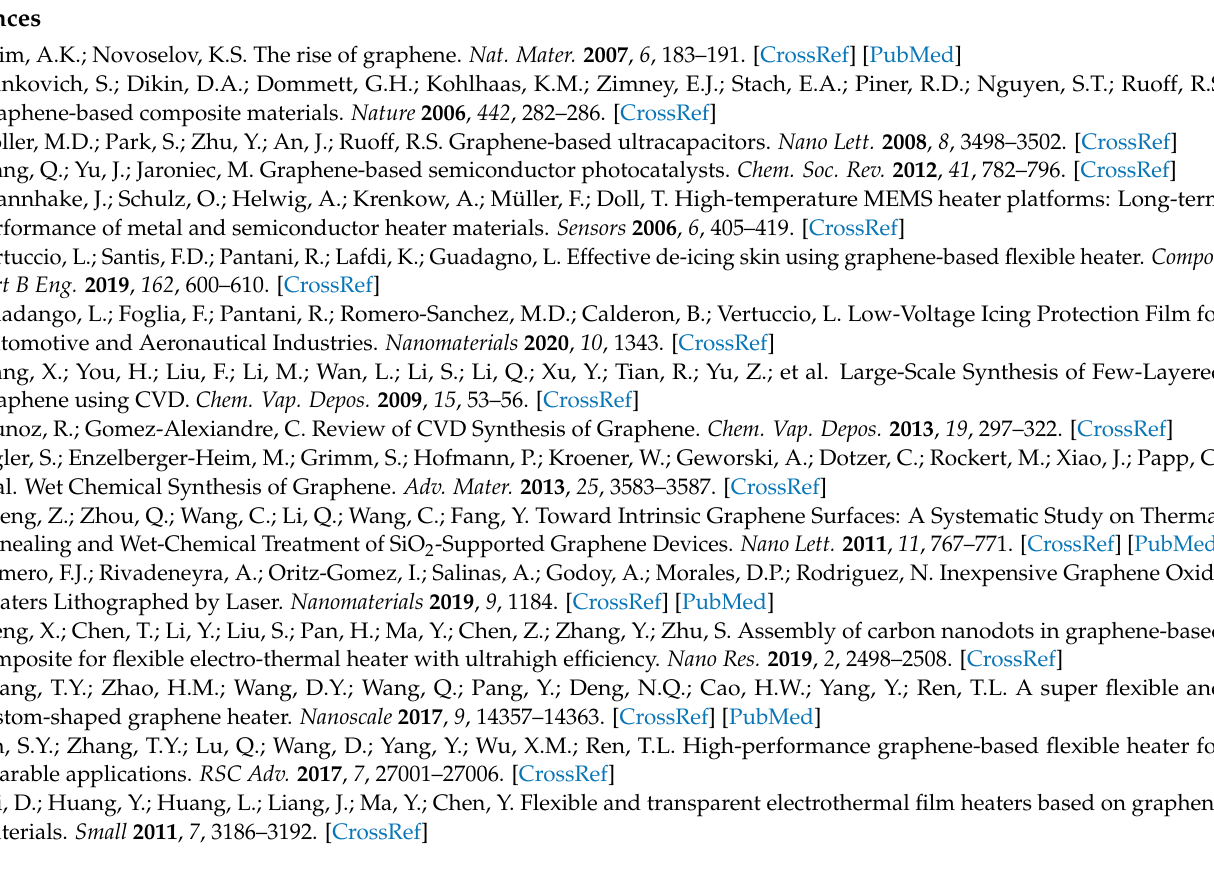
state, (c) Electrode patterns fabricated at scanning speed of 20, 40, 60, 80, and 100 mm/s, Figure S2: TEM images of LIG patterns fabricated at scanning speed of 60 mm/s; (a) 500 nm, (b) 100 nm, (c) 10 nm scale bar, Figure S3: Electrothermal test of the flexible LIG heater (150 mm 2 ) without silver paste; (a) 1–12 V voltage applied to LIG heater using the power supply, (b–m) Infrared image of the LIG heater (27.5–196.4 ◦ C), Figure S4: The temperature–voltage curve of LIG heater; (a) Sample size 40 mm × 2.5 mm LIG heater, and (b) Sample size 30 mm × 5 mm LIG heater. The temperature– voltage curve for the same sample with the existence of silver paste at (c) scanning speed of 20 mm/s, (d) scanning speed of 40 mm/s, (e) scanning speed of 60 mm/s, and (f) scanning speed of 80 mm/s, Figure S5: Resistance (blue) and current (red) over time speed for voltages of 10 V: LIG heater fabricated according to laser scanning (a) 20 mm/s, (b) 40 mm/s, (c) 60 mm/s, and (d) 80 mm/s, Figure S6: Evaporation test of water droplet (0.05 mL) with LIG heater pad/aluminum